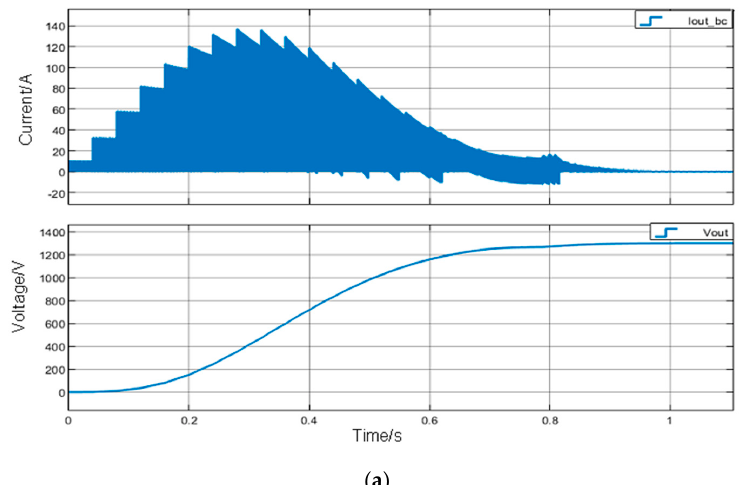
Figure 11. Output current and switching frequency regulation of the DCX#2 and DCX#3. ( a ) Output current changing with the switching frequency of DCX#2; ( b ) Switching frequency regulation of DCX#2; ( c ) Output current changing with the switching frequency of DCX#3 and ( d ) Switching frequency regulation of